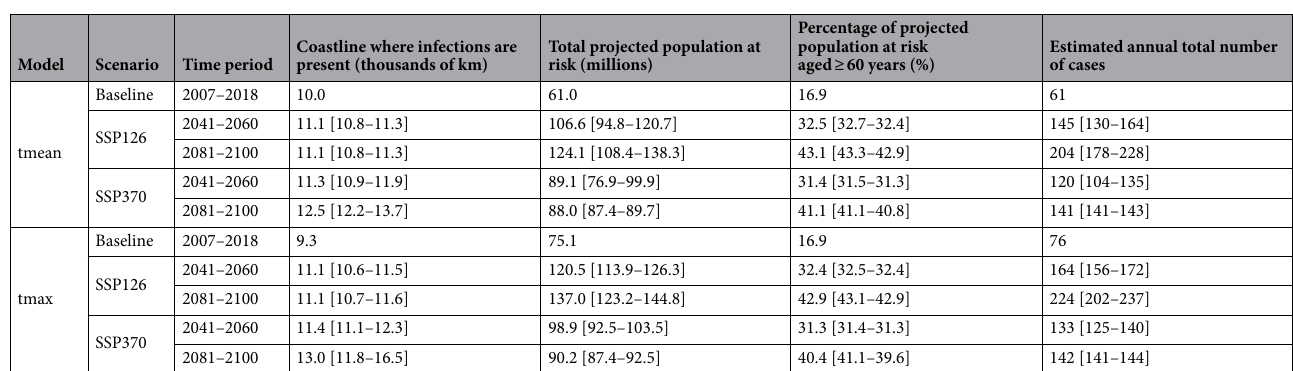
Table 1. Length of coastline where V. vulnificus infections are present (thousand km) population at risk (millions), percentage of population aged ≥ 60 and estimated annual number of V. vulnificus cases under CMIP6 Shared Socioeconomic Pathways SSP126 and SSP370. Values are the ensemble mean from seven global climate models and the minimum and maximum estimates are given in square